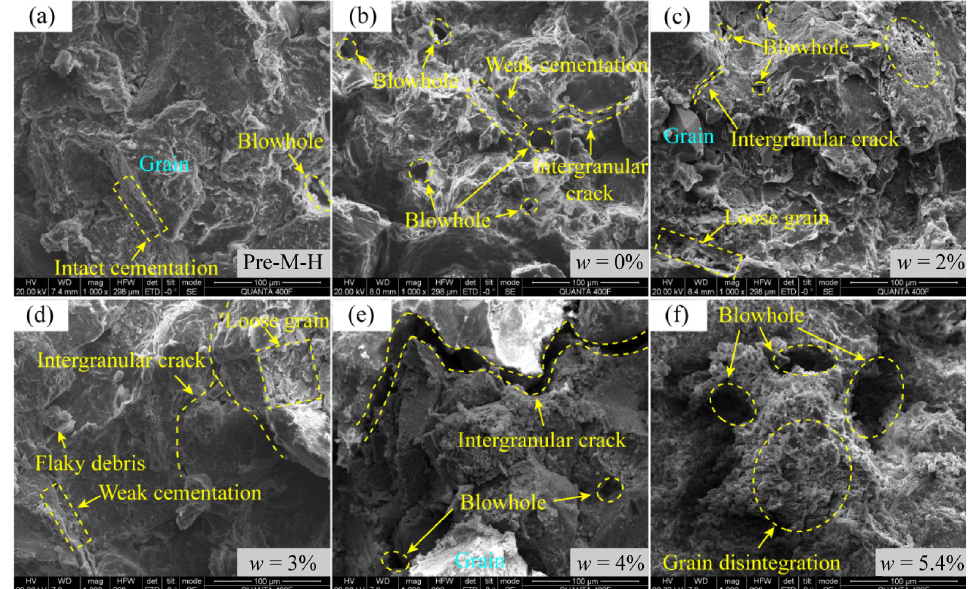
Figure 16. SEM observations of microwave irradiated sandstone with different initial water content. ( a ) Pre-M-H, ( b ) w = 0%, ( c ) w = 2%, ( d ) w = 3%, ( e ) w = 4%, ( f ) w = 5.4%.